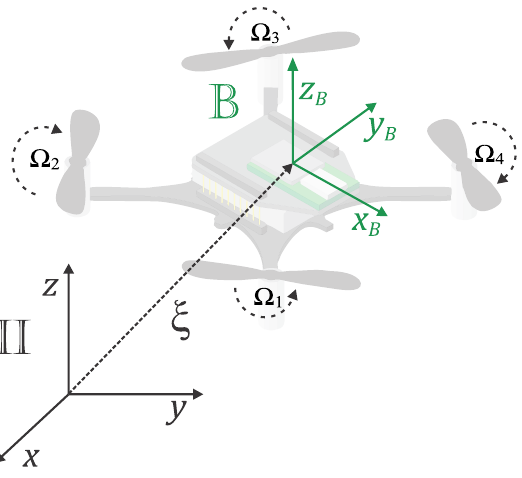
Figure 1. Coordinate systems of a quadrotor.